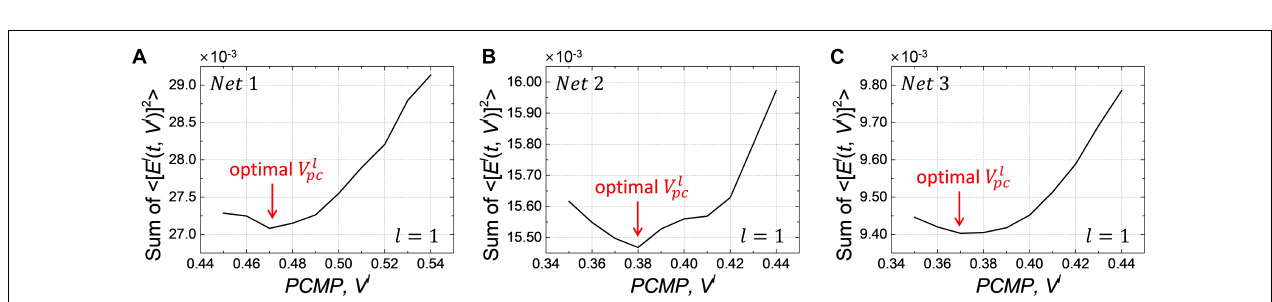
FIGURE 7 | (A) Changes of MSE for Net 3 when increasing the amount of the global V pc from 0.0 to 0.5 with 0.1 steps. MSE decreases more quickly as the global V pc increases. (B) The average firing rate in the output layer with the different levels of the global V pc according to the simulation timestep. Restored sample image in the output layer of Net 3 at 50, 100, 150, 200, and 255th timestep for the global V pc of (C) 0.0 and (D) 0.5.